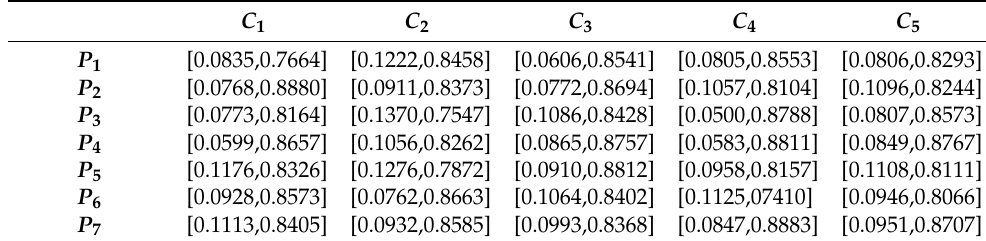
Table 7. Comprehensive selection criteria information.